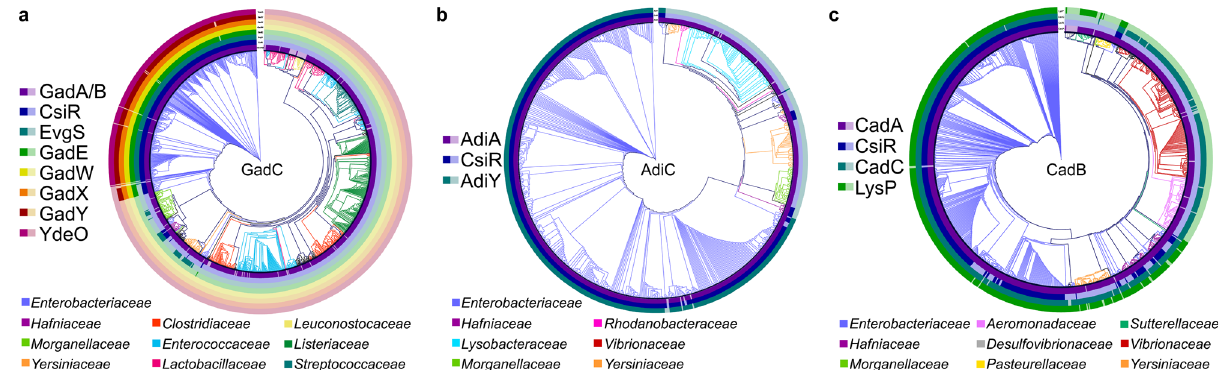
Fig. 4 Phylogenetic trees of the E. coli antiporters GadC, AdiC, and CadB and co-occurring regulators of the three AR systems within the bacterial kingdom. a The protein sequences of 1112 of E. coli GadC homologs were aligned, and a phylogenetic tree was generated, which is shown as a circular cladogram. The branches of the tree were colored according to the family of the organisms containing a GadC homolog. The presence of different regulatory components CsiR, EvgS, GadE, GadW, GadX, GadY, and YdeO and the decarboxylases GadA and GadB (GadA/B) is indicated by solid colors in the respective ring layer. Translucent colors represent components that were not detected. b The protein sequences of 756 E. coli AdiC homologs were aligned, and a phylogenetic tree was generated, which is shown as a circular cladogram. The branches of the tree are colored according to the family of organisms containing an AdiC homolog. The presence of the different regulatory components CsiR and AdiY as well as the decarboxylase AdiA is indicated by solid colors in the respective ring layer. If these components were not found, the colors are translucent. c The protein sequences of 857 E. coli CadB homologs were aligned, and a phylogenetic tree was generated, which is shown as a circular cladogram. The branches of the tree are colored according to the family of organisms containing a CadB homolog. The presence of the different regulatory components CsiR, CadC, and LysP as well as the decarboxylase CadA are indicated by solid colors in the respective ring layer. Translucent colors represent components that were not detected. Identi fi ers of all GadC, AdiC, and CadB homologs with an indication of the presence or absence of their main regulators are summarized in Supplementary Data